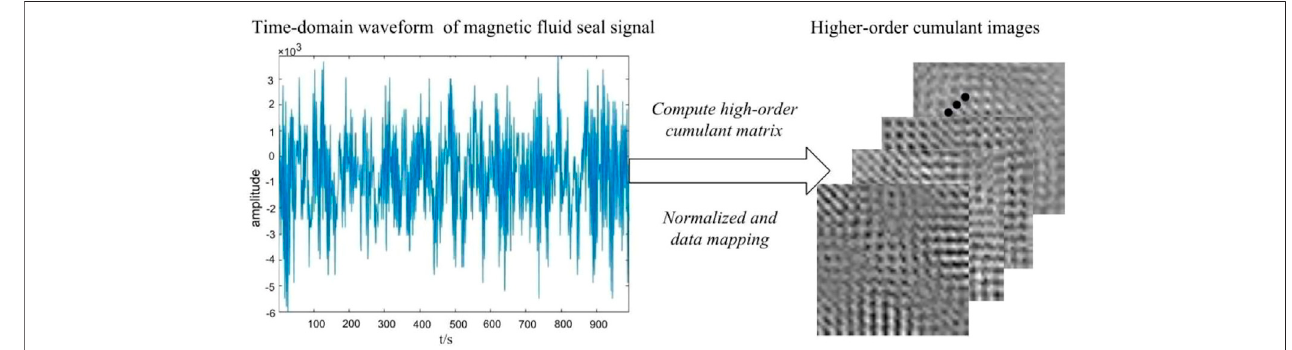
FIGURE 1 | Schematic diagram of high-order cumulant image transformation process in the magnetic fl uid seal